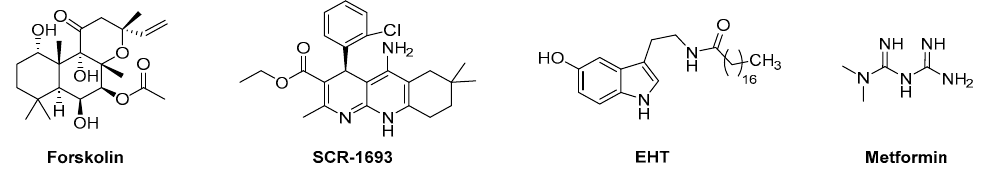
Figure 7. Chemical structures of PADs acting on the post-transductional processing of PP2A.